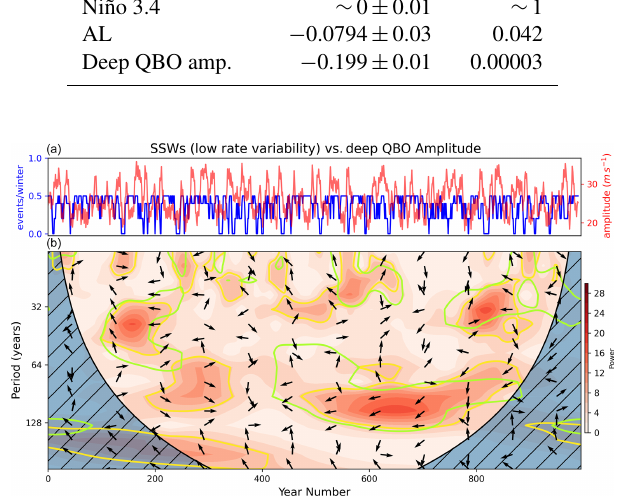
Figure 13. (a) SSW 5 years time series with variability in high SSW rate intervals removed by setting all rates above the climatological mean (0.54 events per season) to the mean (blue) and September– November deep QBO Hilbert amplitude index smoothed with a 5- year window (red). (b) Cross-wavelet power spectrum between the two time